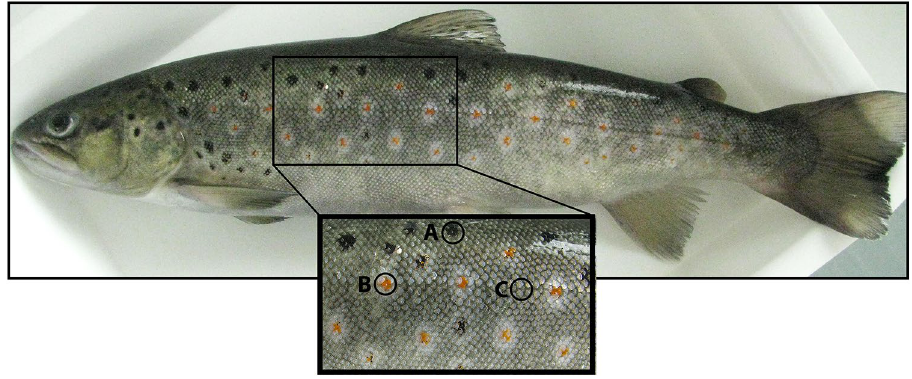
Figure 8. The analysed skin regions of brown trout. ( A ) black spot, ( B ) red spot, and ( C ) background colour